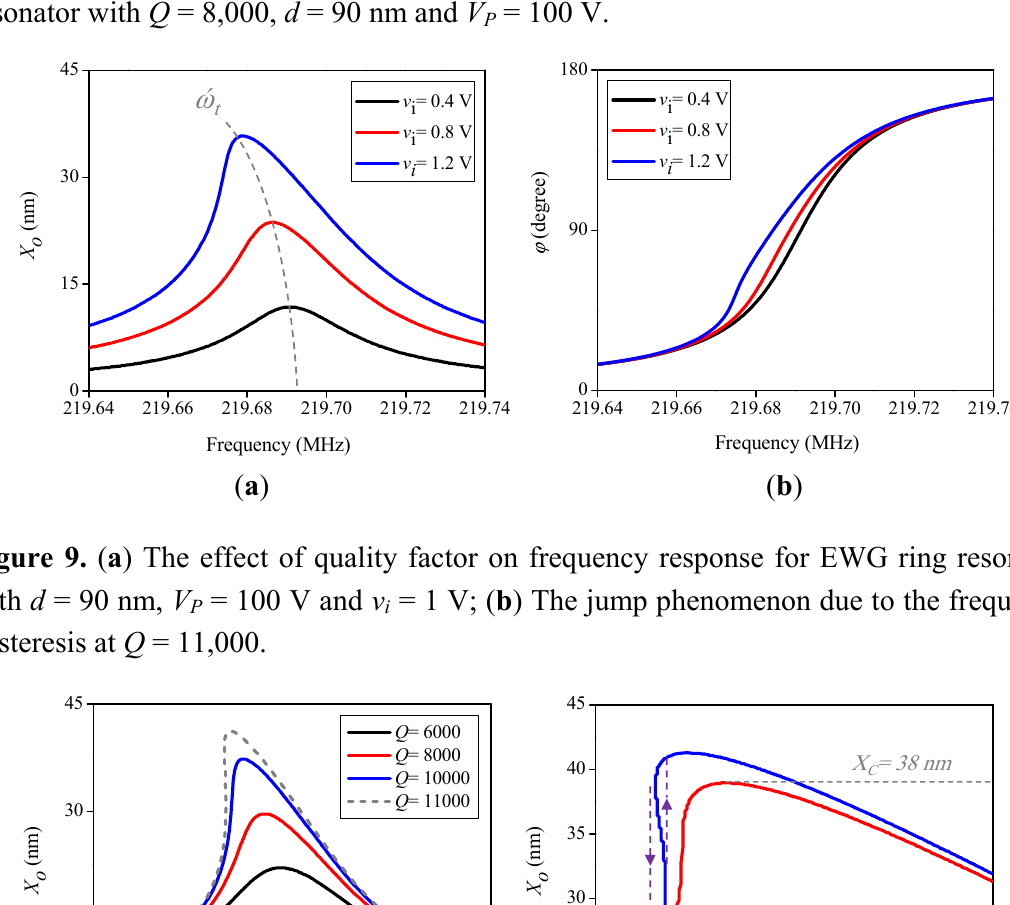
Figure 8. The effect of ac -drive voltage on frequency response for EWG mode ring resonator with Q = 8,000, d = 90 nm and V